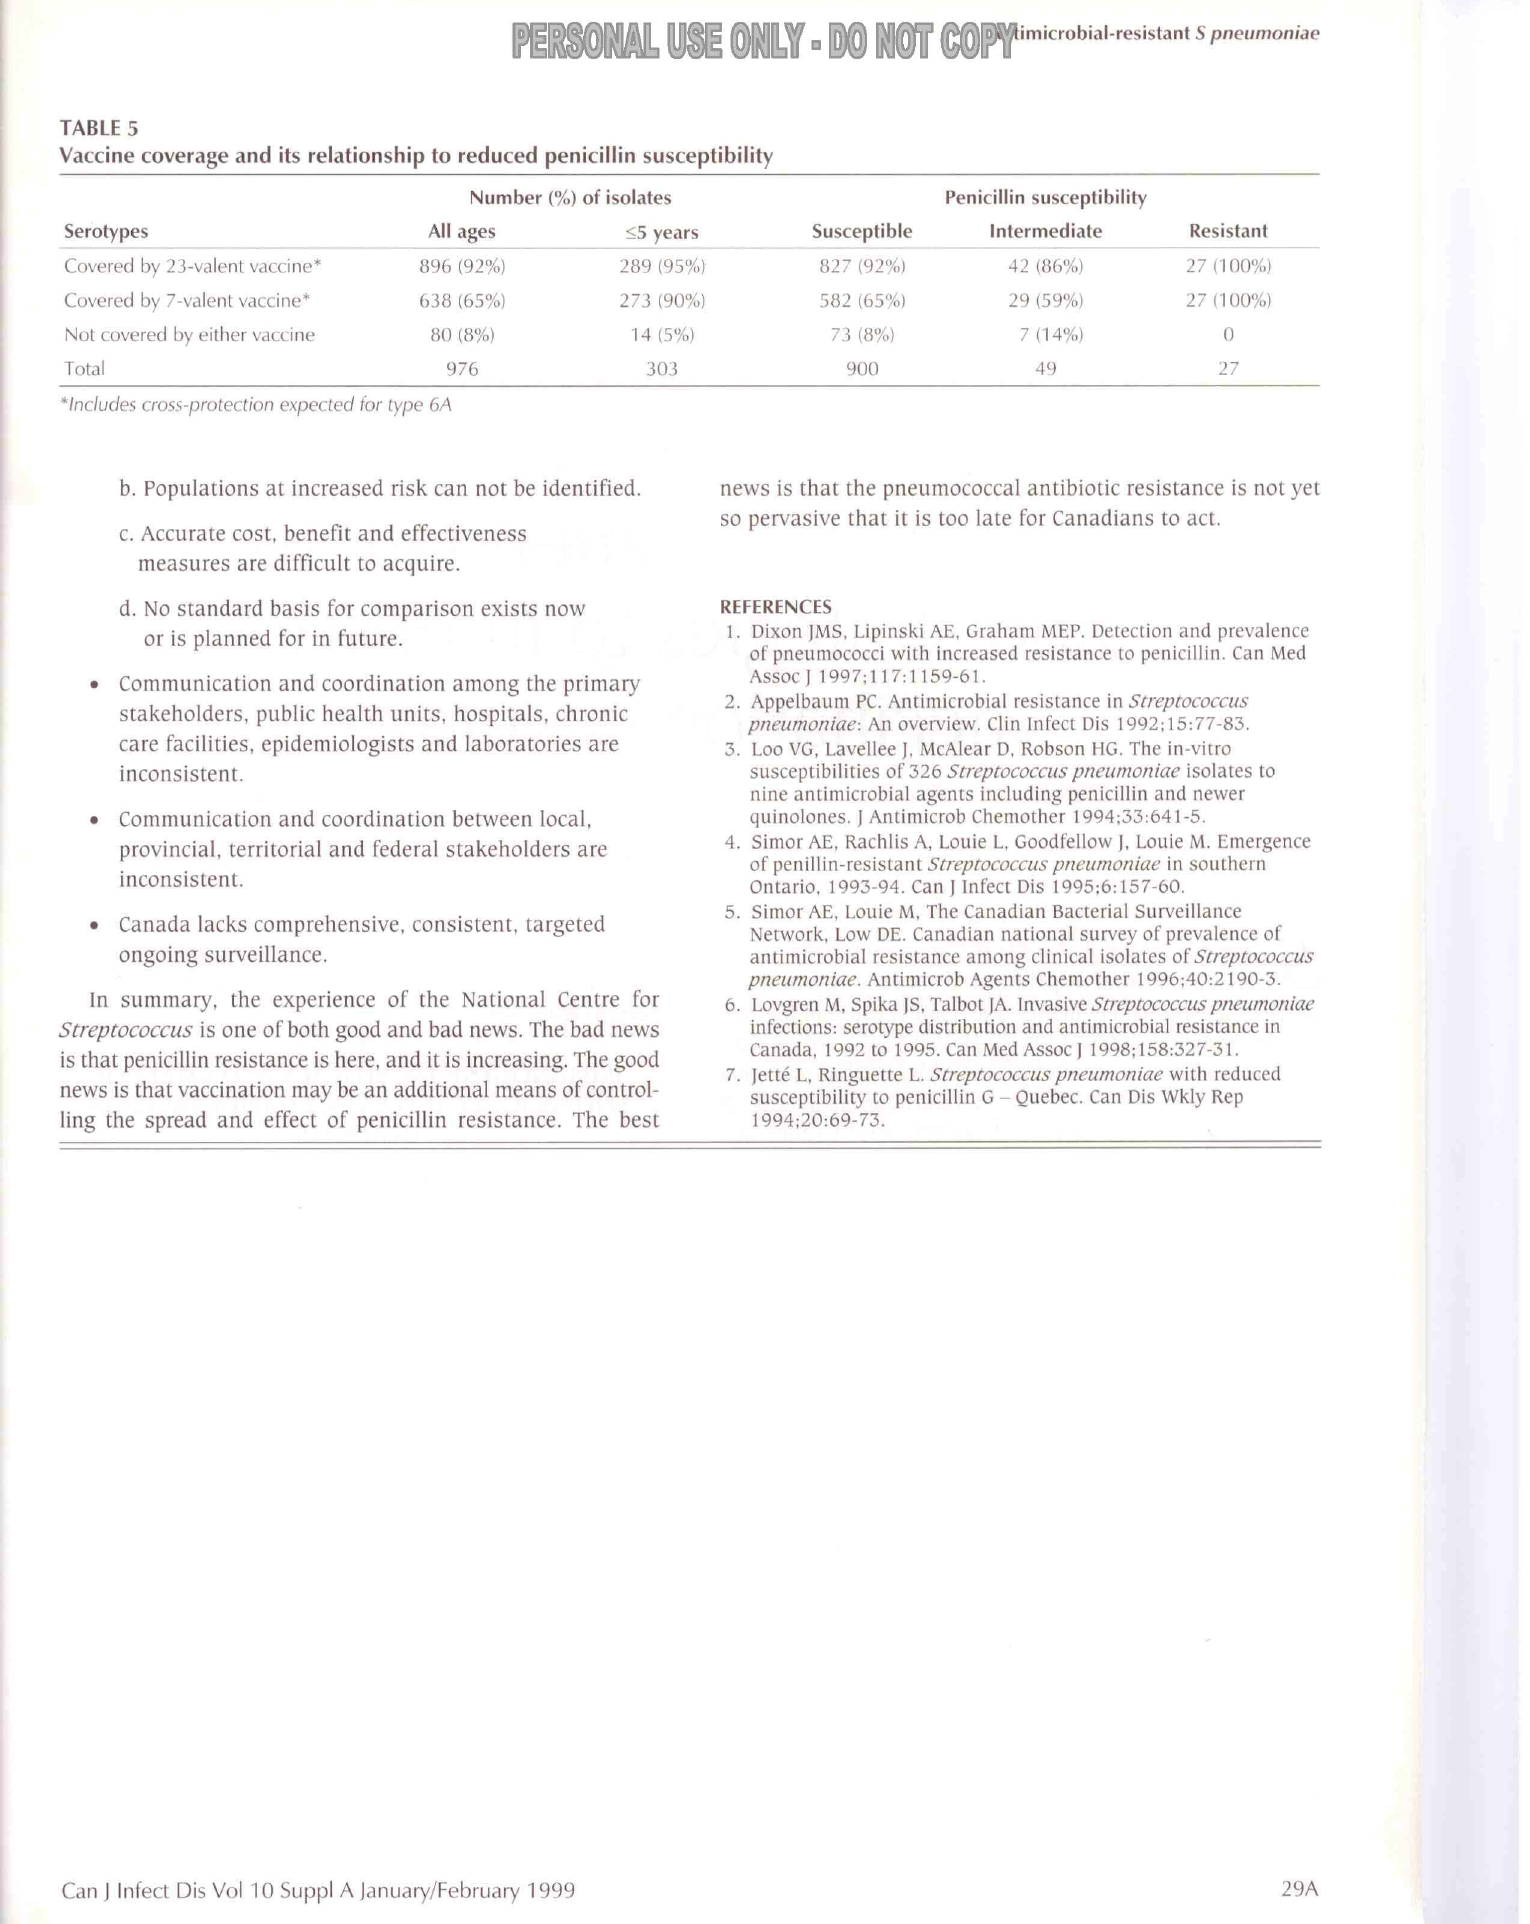
Vaccine coverage and its relationship to reduced penicillin